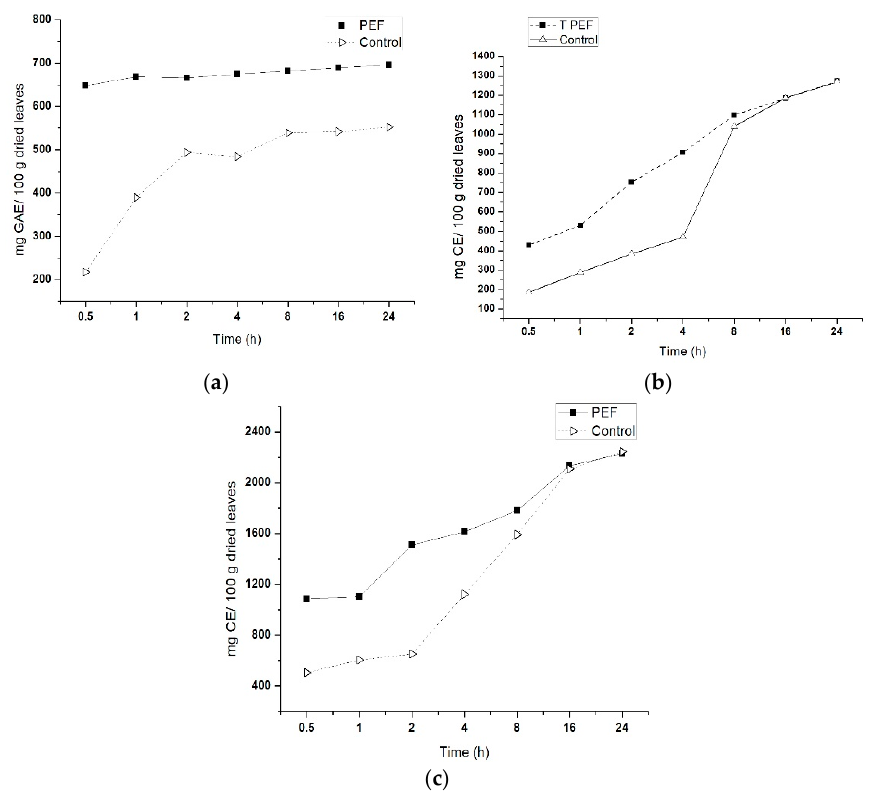
Figure 6. Extraction kinetics of the three compounds.( a )Total phenols; ( b )Total flavonoids; ( c ) Con- densed tannins.